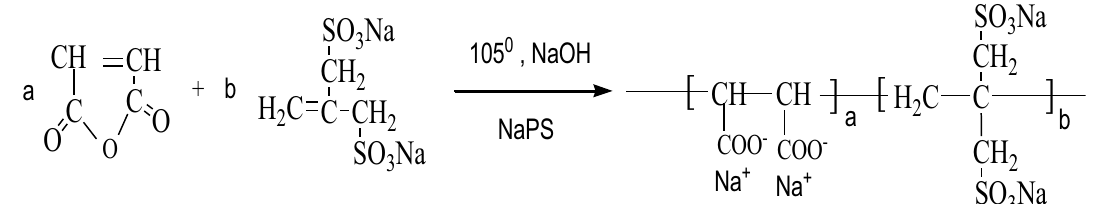
Fig. 1 MA-SMADS Copolymer (Maleic anhydride and Sodium methallyl